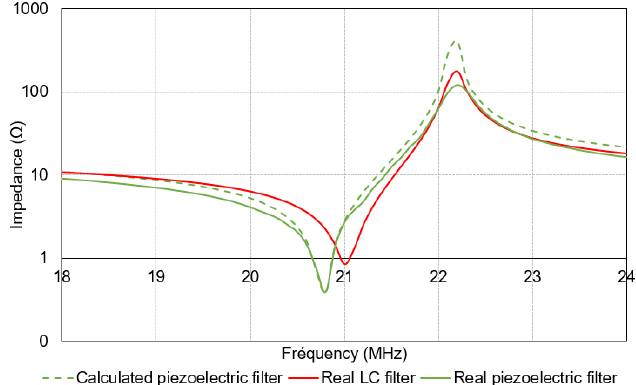
Figure 11. Comparison of calculated and measured impedance filters around the main thickness resonant frequency.